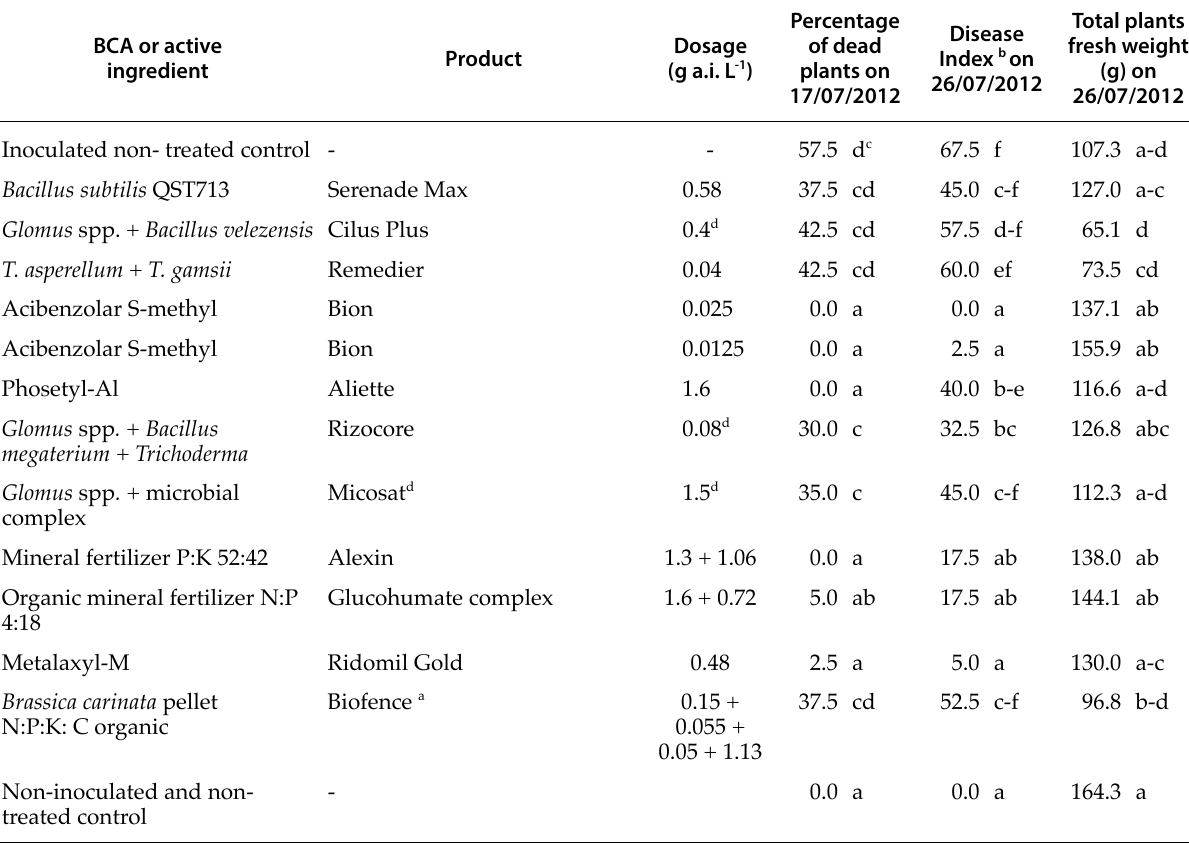
Table 5. Trial 3. Mean proportions of dead plants, mean disease indices (0-100) and mean total plant fresh weights, for tomato plants receiving different